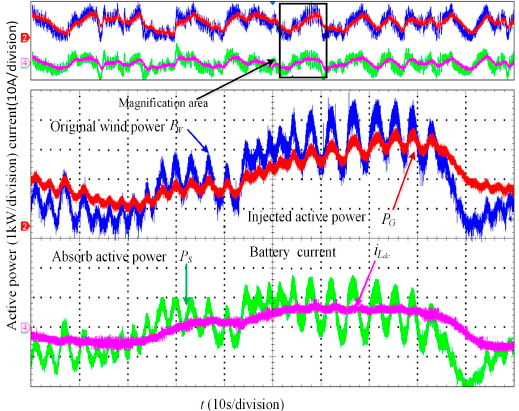
Figure 15. Experimental results when P G is the low-frequency fluctuations of P W .